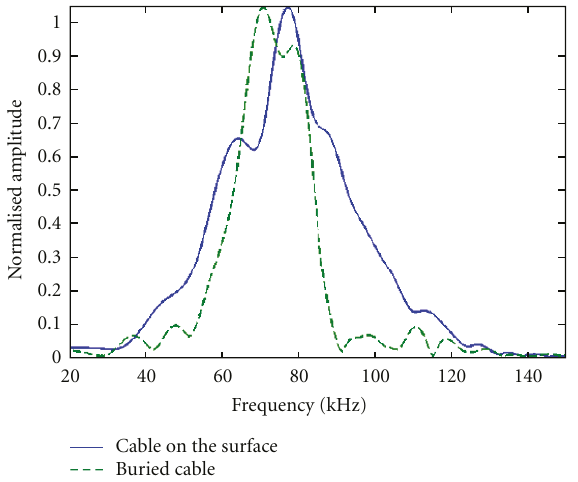
Figure 5: Normalized spectra for the surface cable and for the cable buried with its top surface flush with the sediment.